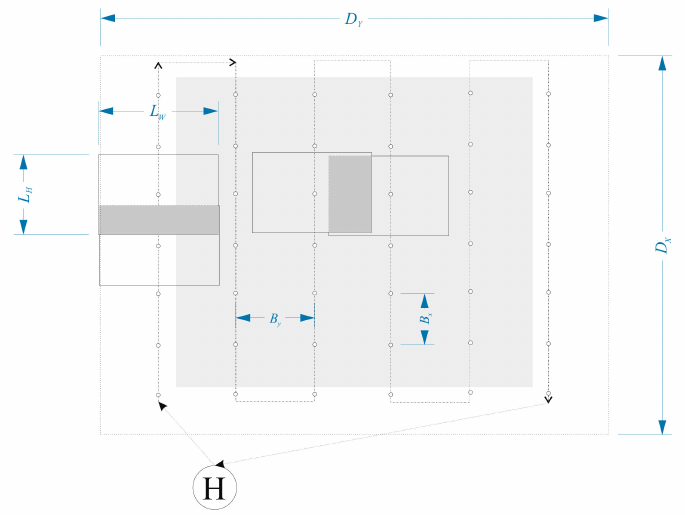
Figure 2. Single-grid flight path—scheme and